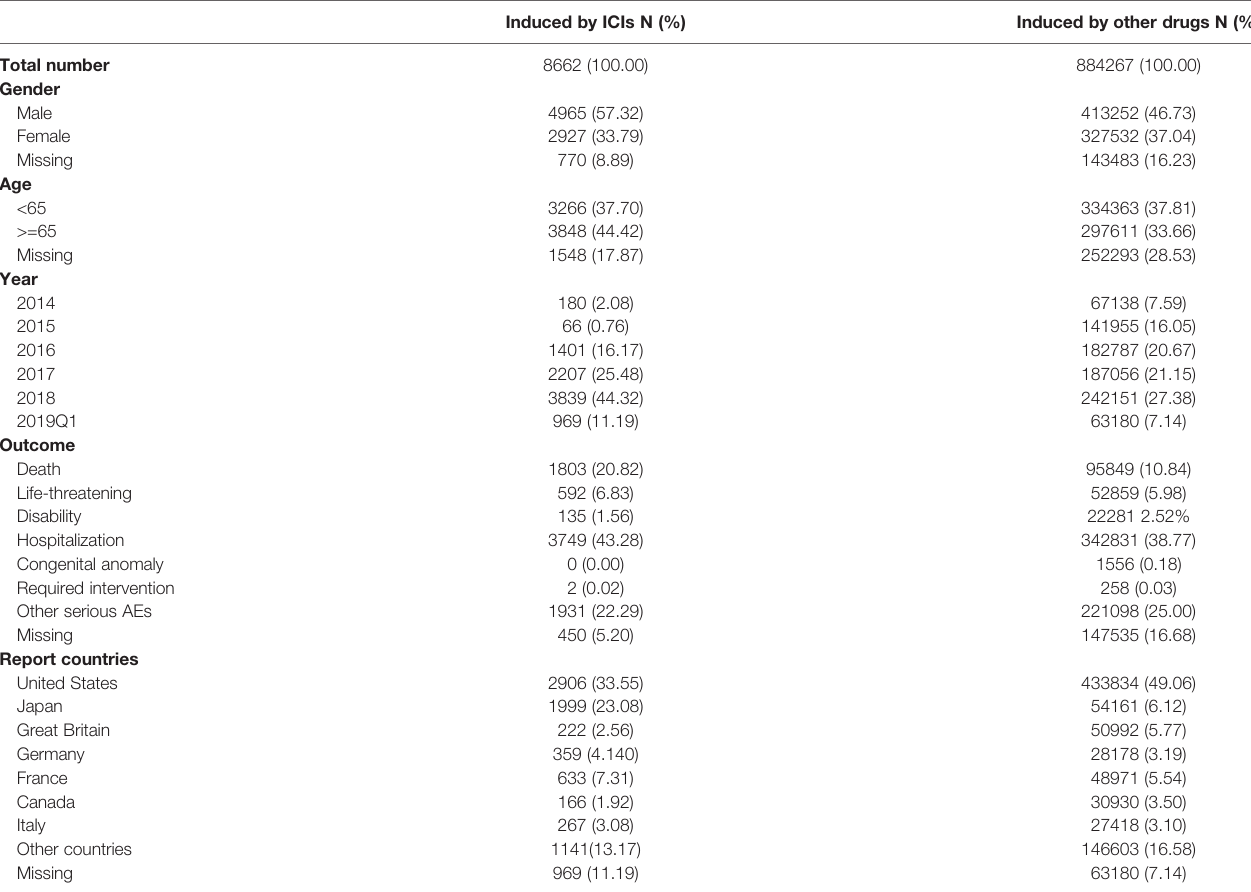
TABLE 1 | Clinical characteristics of patients with metabolic and nutritional